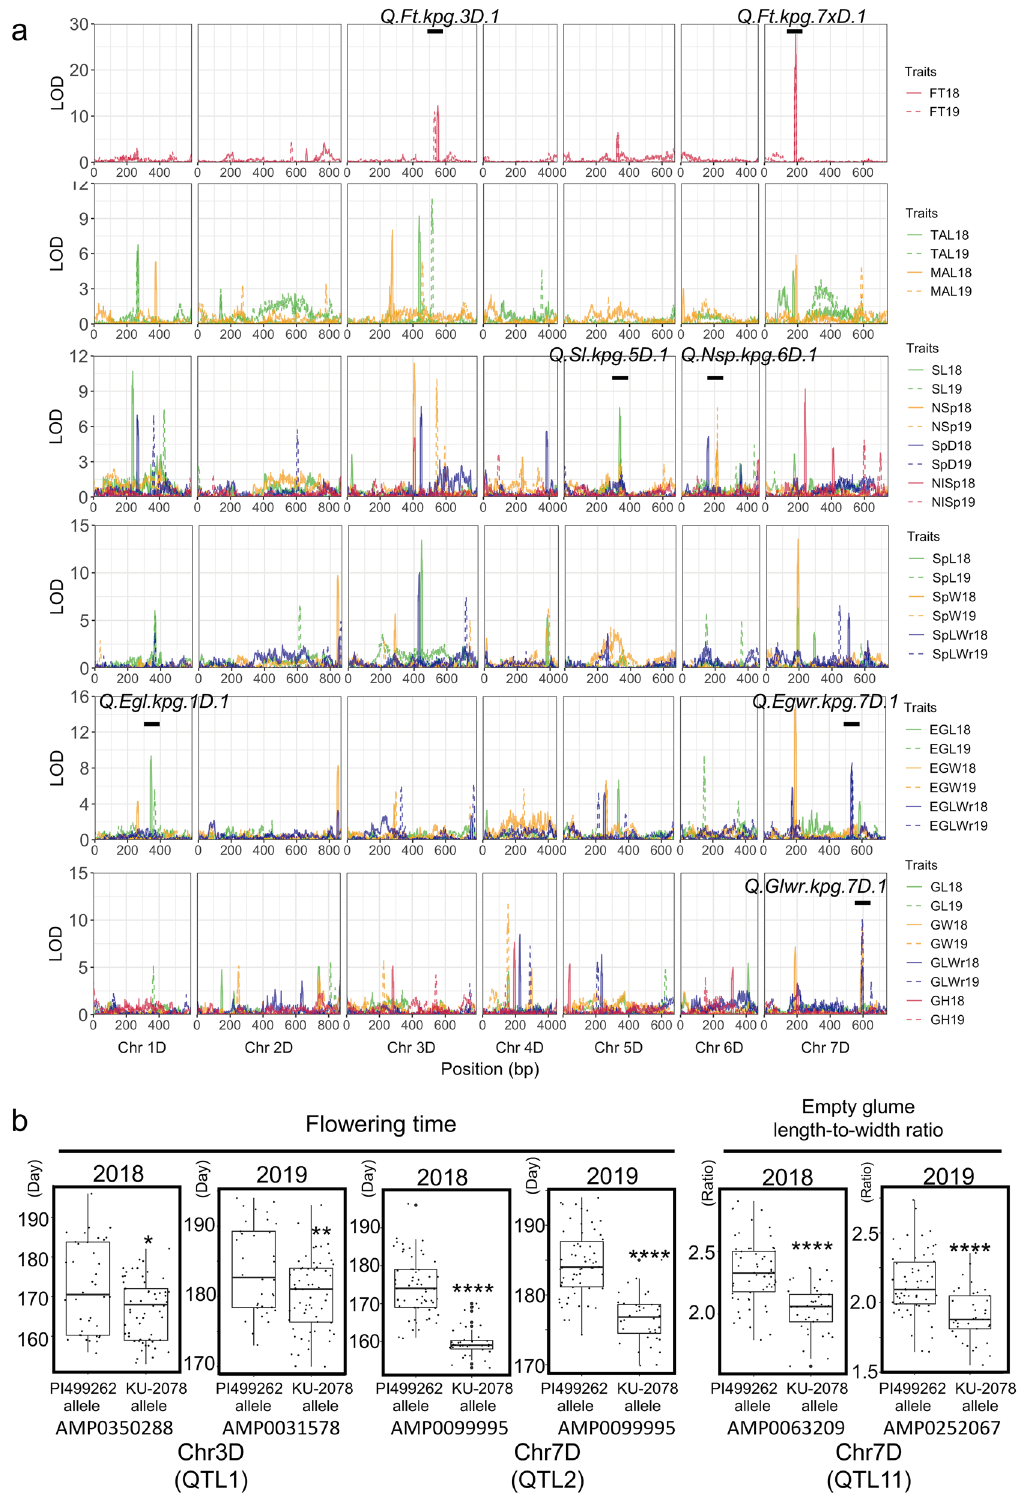
Figure 3. QTL analysis of Ae. tauschii KU-2078/PI499262 RILs. ( a ) Distribution of LOD scores for the 17 traits over the linkage map. The x-axis indicates the positions of the linkage map (cM), and the y-axis represents the LOD score. Positions of stable QTLs shown in Table 1 were marked as numbers one to seven on each peak. ( b ) Box and dot plots for flowering time and empty glume length-to-width ratio between RILs having the PI499262 allele and RILs having the KU-2078 allele at the QTL-linked markers in the 2017–2018 and 2018–2019 seasons. Welch’s two-sample t-test was performed to assess statistical significance between the two genotypes of the RILs (*P < 0.05, **P < 0.01, ***P < 0.005, ****P < 0.001). Plots were created with the R package ggplot2 (Wickham